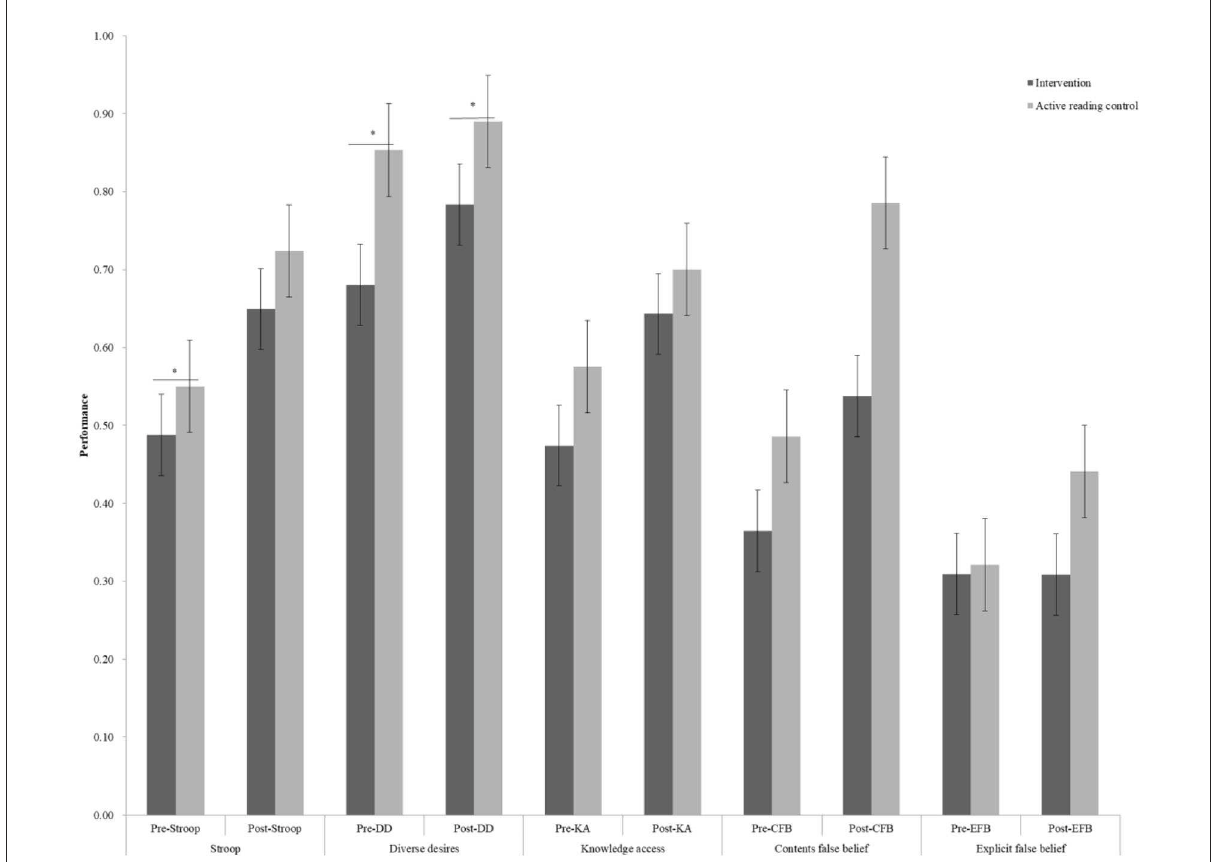
FIGURE7 Cognitive and social-cognitive pre- and post-performance between the intervention group and active reading control group. Stroop, inhibitory control; DD, diverse desires; KA, knowledge access; CFB, contents false belief; EFB, explicit false belief, * p <